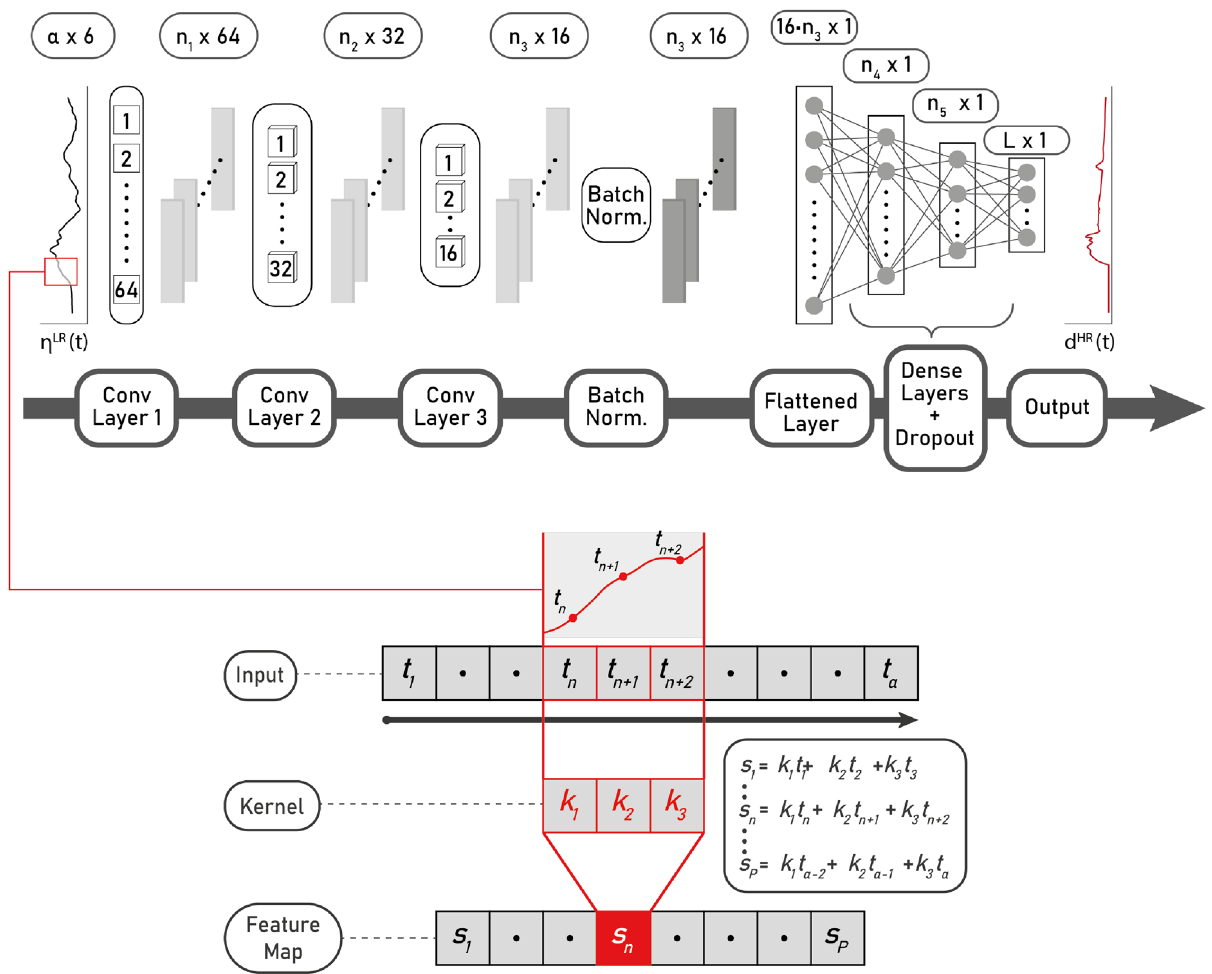
Figure 3. Schematic of the network architecture. Top panel shows all steps using the nomenclature specified in the text. Bottom panel shows represents the feature extraction from a convolutional